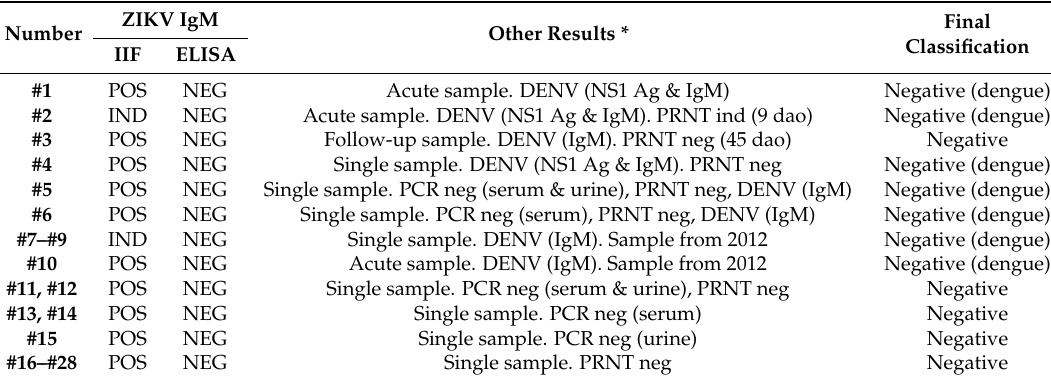
Table 2. Discrepant results finally classified as negative.